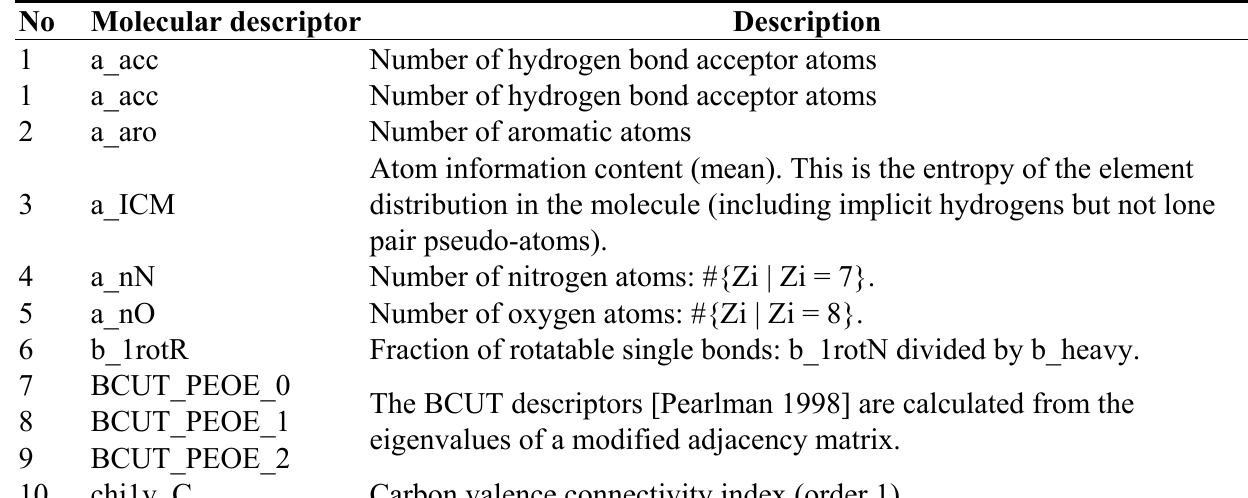
Table 7. Description of 35 molecular descriptors using to create the 2D QSAR